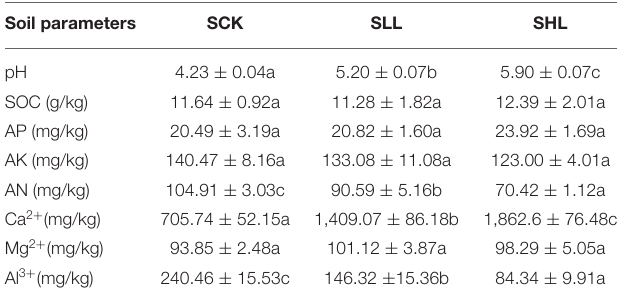
TABLE 1 | Changes in soil properties of HLB-infected citrus root-zone soil with low slaked lime (SLL) and high slaked lime (SHL) applied to the soil surface. Soil